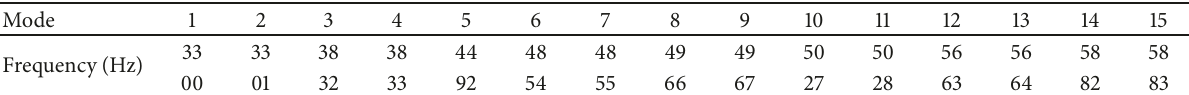
Table 4: Impeller natural modes.